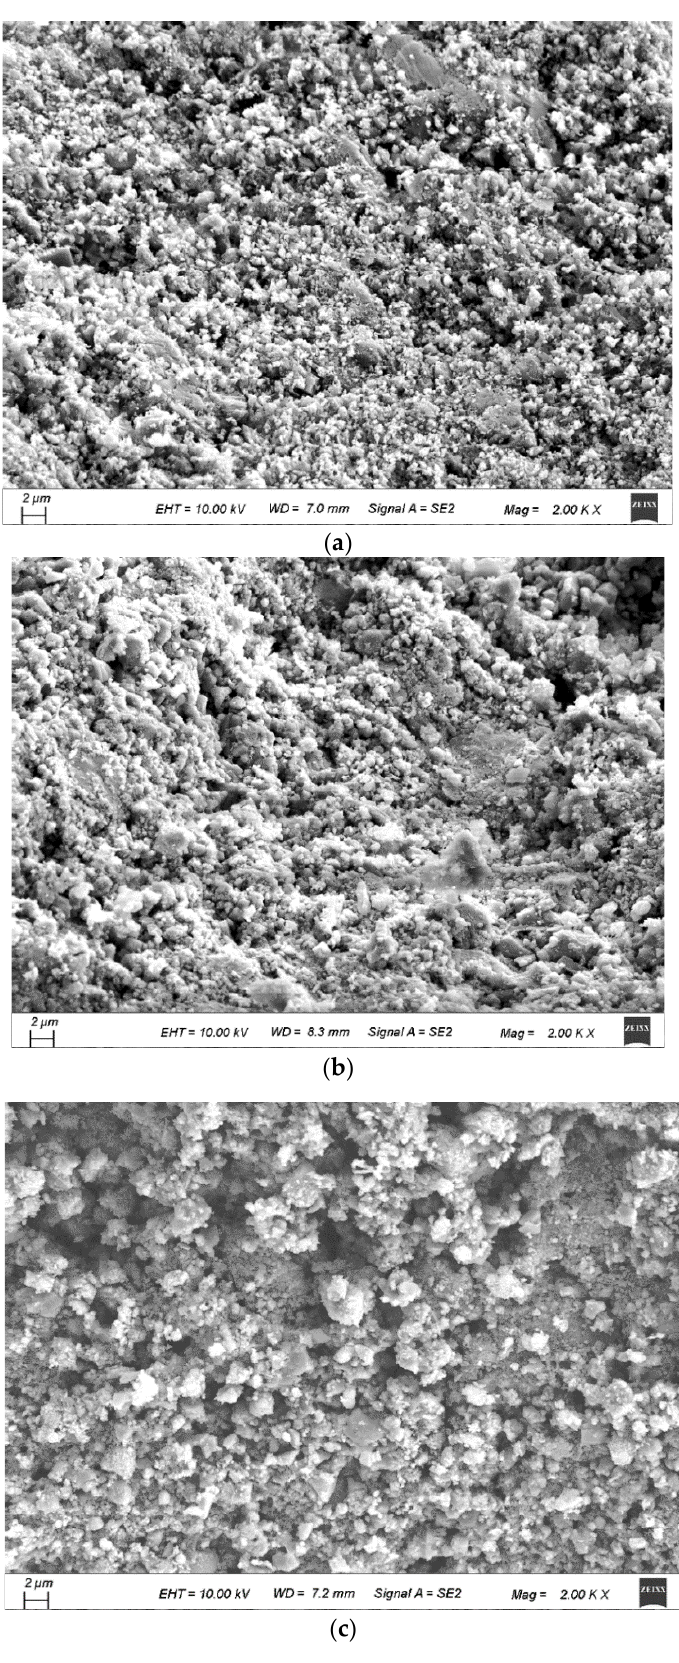
Figure 19. Surfaces of the treated RCA. ( a ) S_C1.0; ( b ) I_C1.0; ( c ) S_CS1.0. According to the results of the DWA of the RCA, the water absorption rate of the RCA was very fast, and after about 30 s, the saturation degree exceeded 60%, while Yang yunqi [42] reported that the saturation reached more than 67.7% within 1 min. On the other hand, the penetration of cement particles depended on the penetration of water.